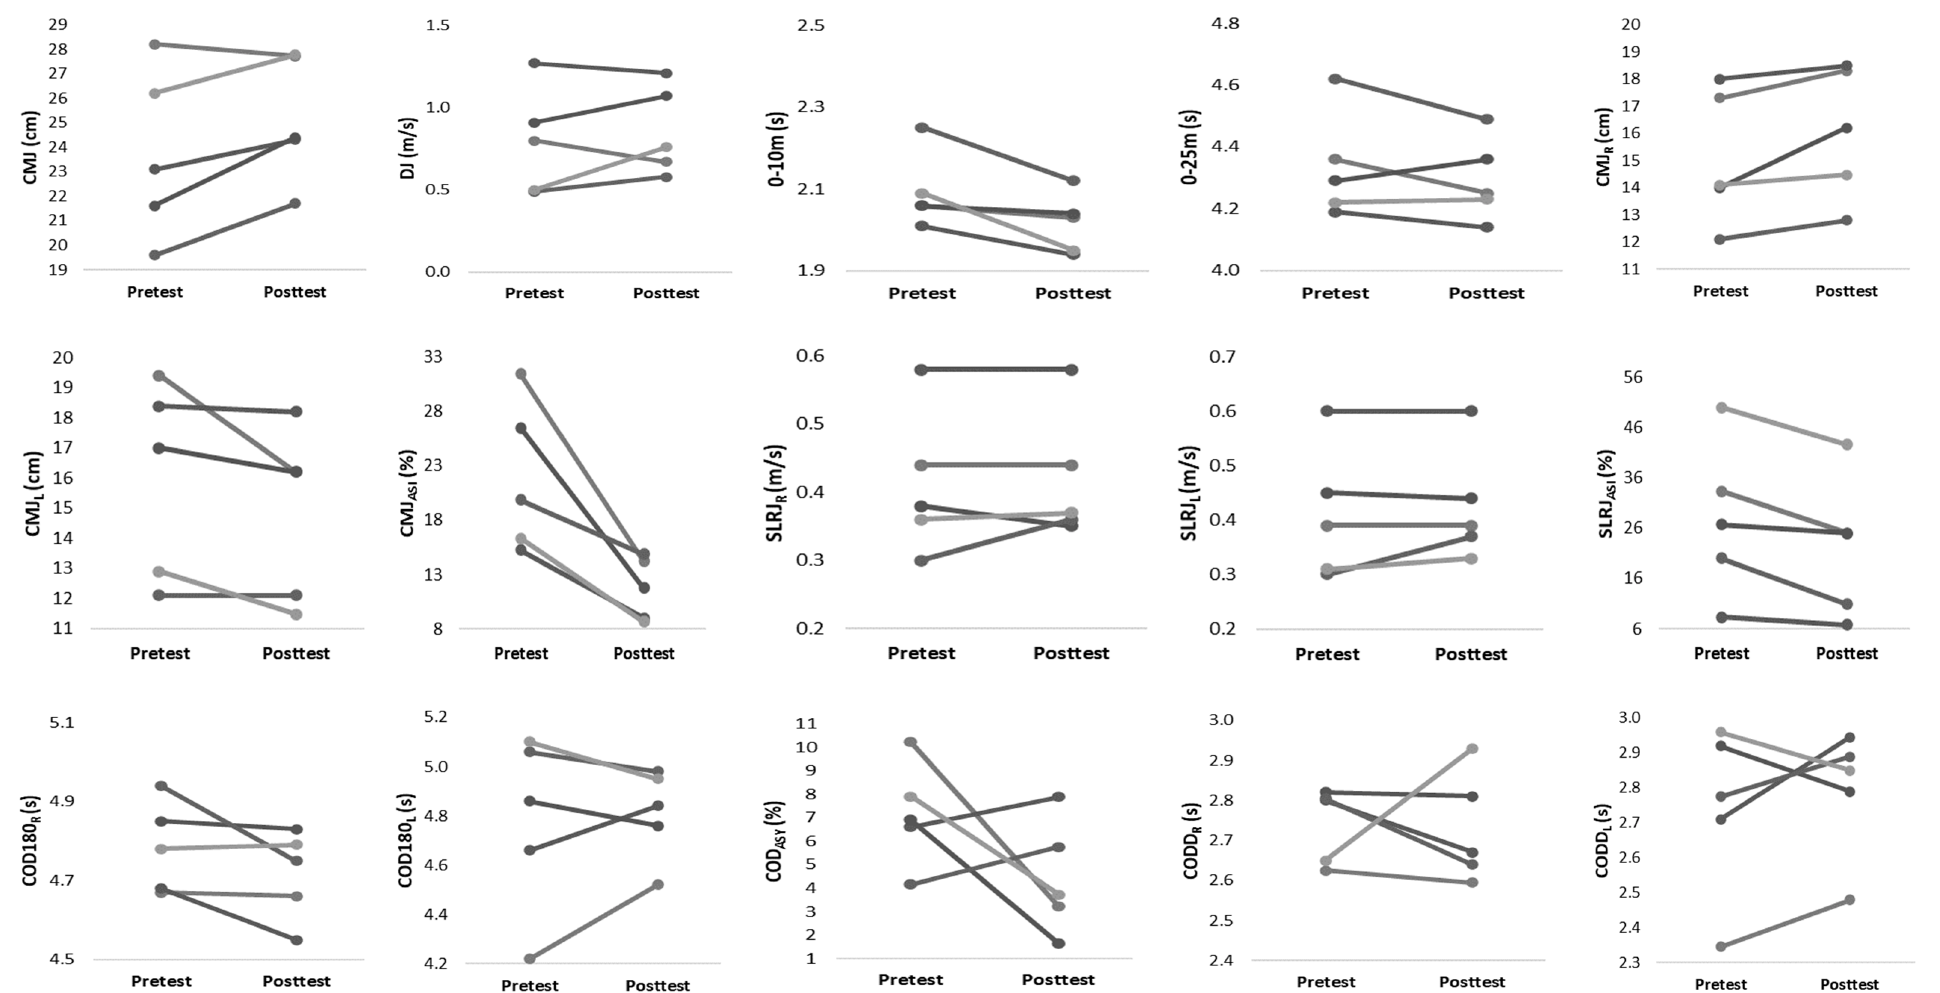
Figure 2. Individual changes from pretest to posttest for physical performance in NCOD group. Figure 3. Individual changes from pretest to posttest for physical performance in NCOD